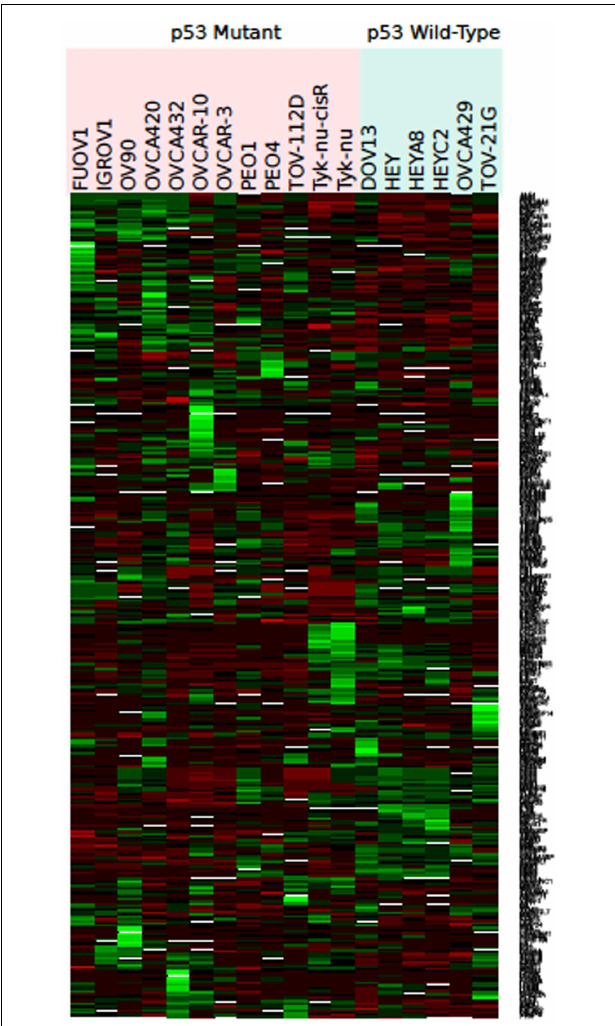
FIGURE 2 | Heat map representing color-coded expression of differentially expressed genes in 18 different wild-type or mutant TP53 cell lines .Twenty-eight genes exhibited statistically significant differential expression by microarray analysis based on TP53